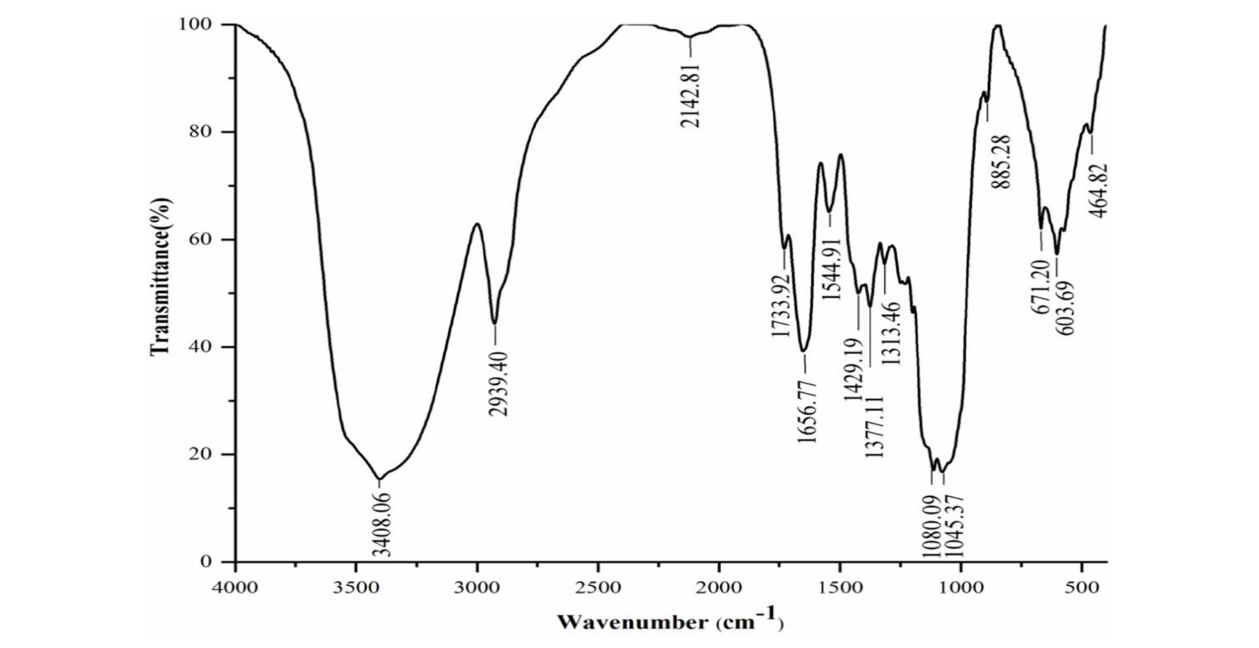
FIGURE 4 | IR spectra of